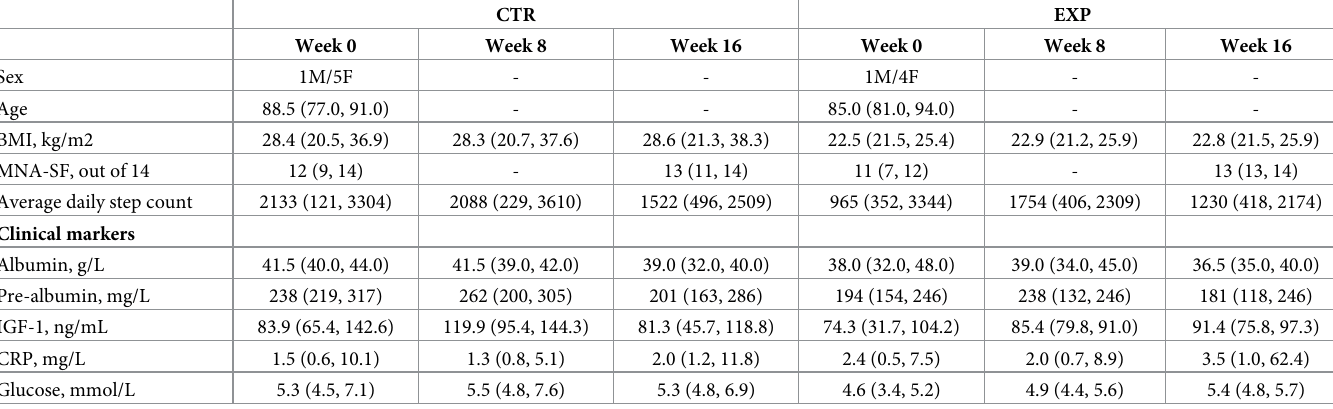
Table 2. Anthropometric measures, step count, and serum clinical markers of participants by